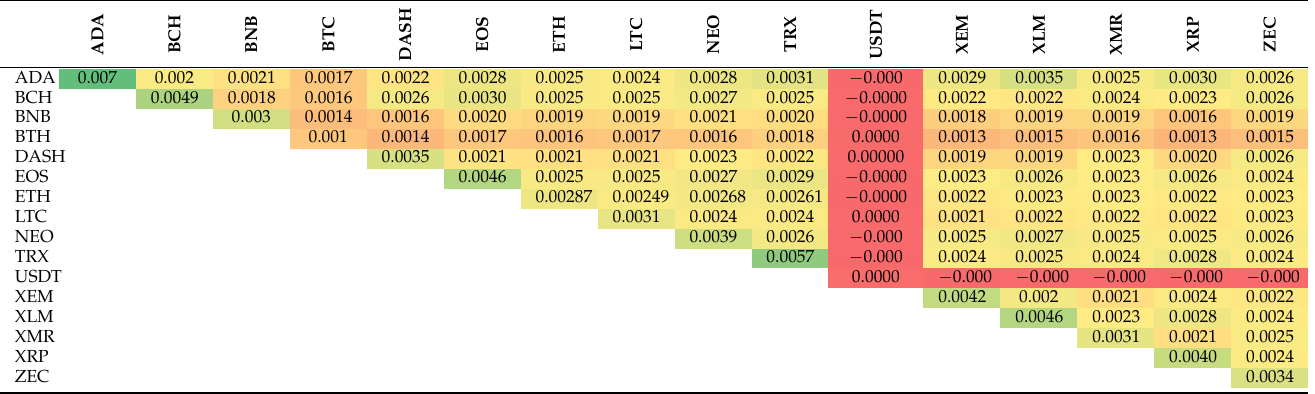
Table A1. A Covariance